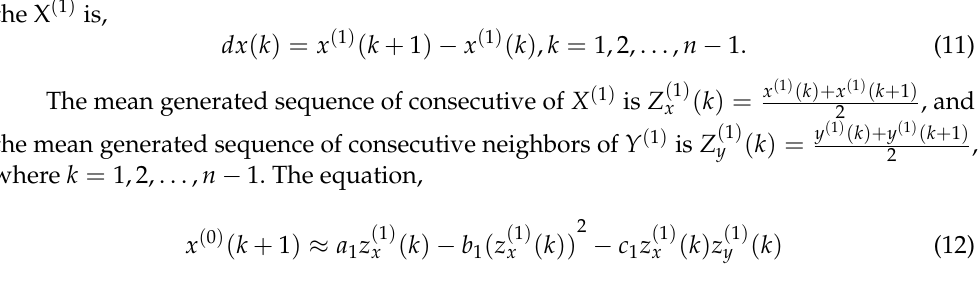
( 1 ) ( k )+ x ( 1 ) ( k + 1 ) ( 1 ) ( k ) = x , and x 2 ( 1 ) ( k )+ y ( 1 ) ( k + 1 ) ( 1 ) ( k ) = y y 2